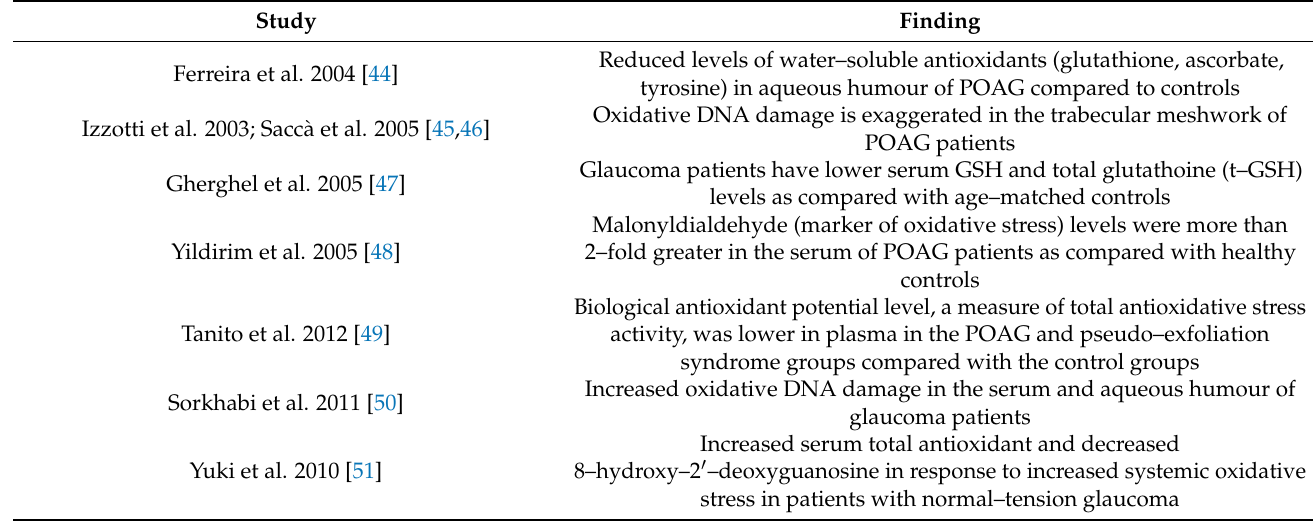
Table 2. Oxidative stress in POAG—human